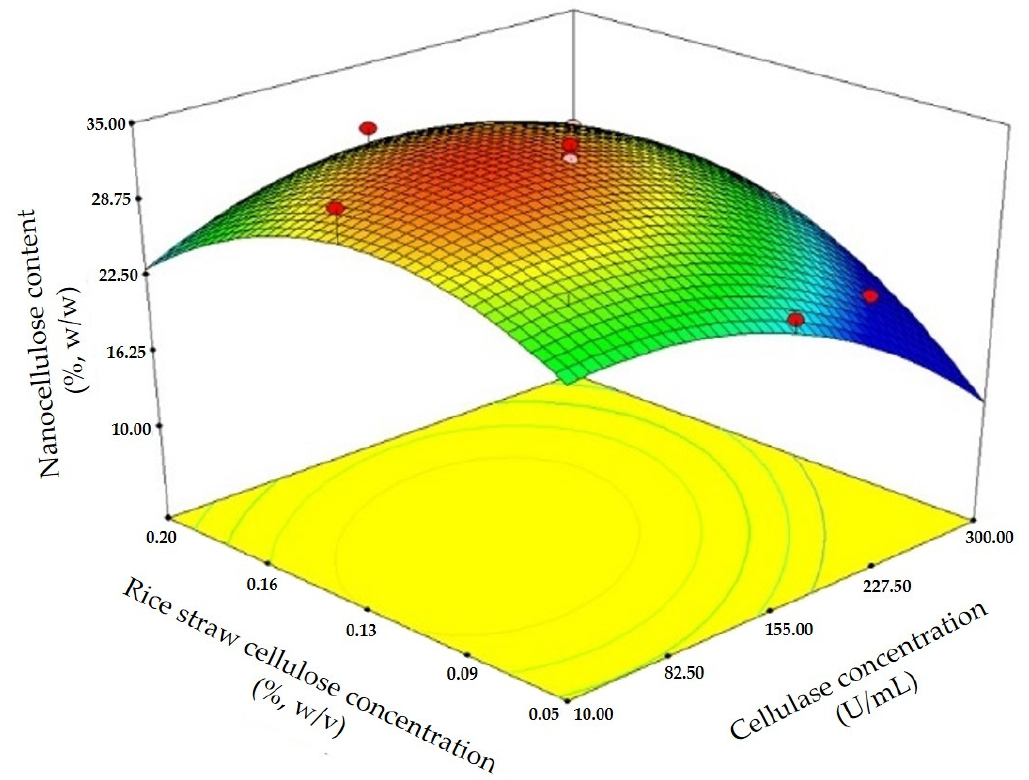
Figure 2. Response surface plot of nanocellulose preparation by enzymatic hydrolysis depends on the varied concentrations of cellulase and rice straw cellulose.